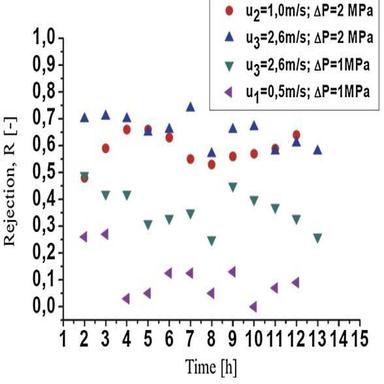
Effect of cross flow velocity and ΔP in rejection of lactic acid.